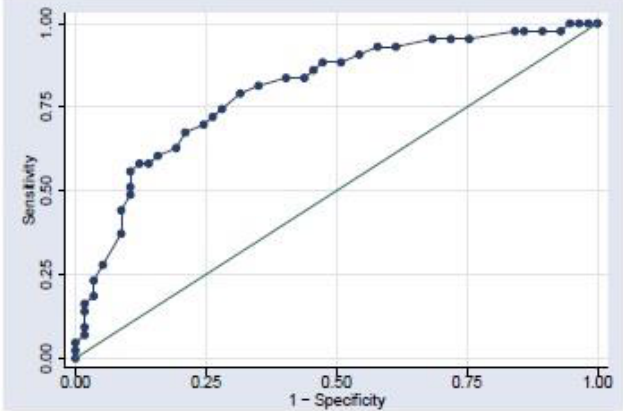
Figure A1. ROC Curve. Source: Heald et al. (2019).